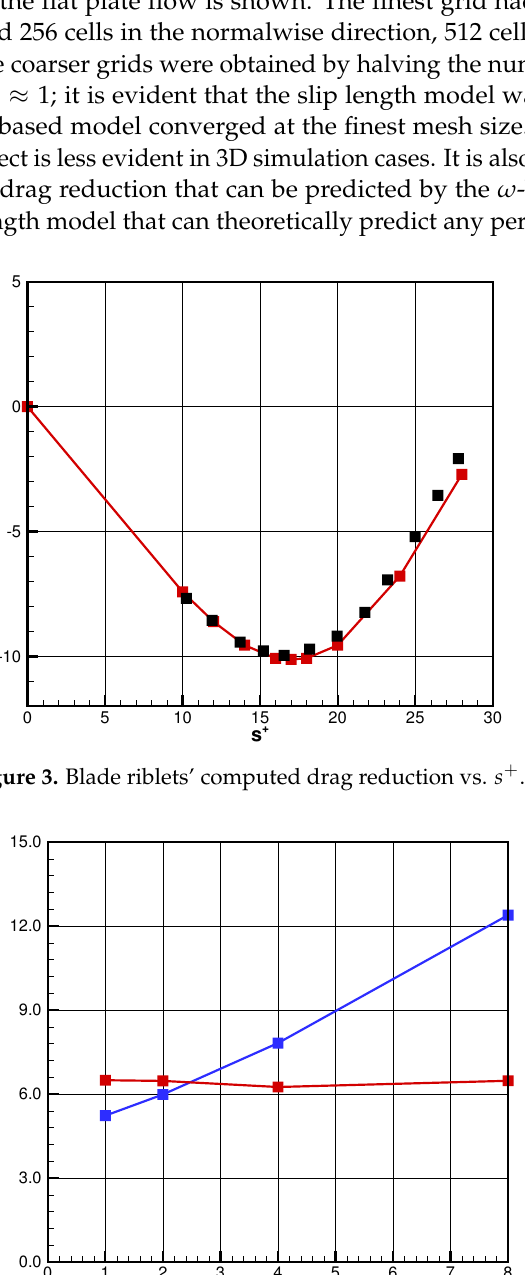
mesh size Figure 4. Drag reduction vs. grid size. Red: Equation (7), blue: Equation